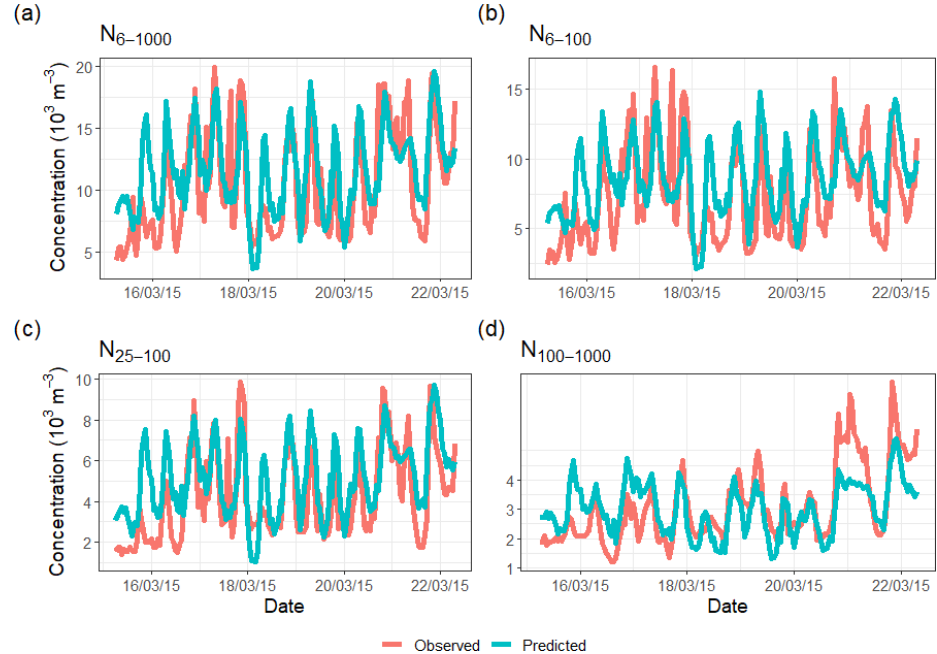
Figure 7. Observed (red line) and predicted (cyan line) time series for an illustrative example period separately in the size fractions of 6–1000, 6–100, 25–100 and